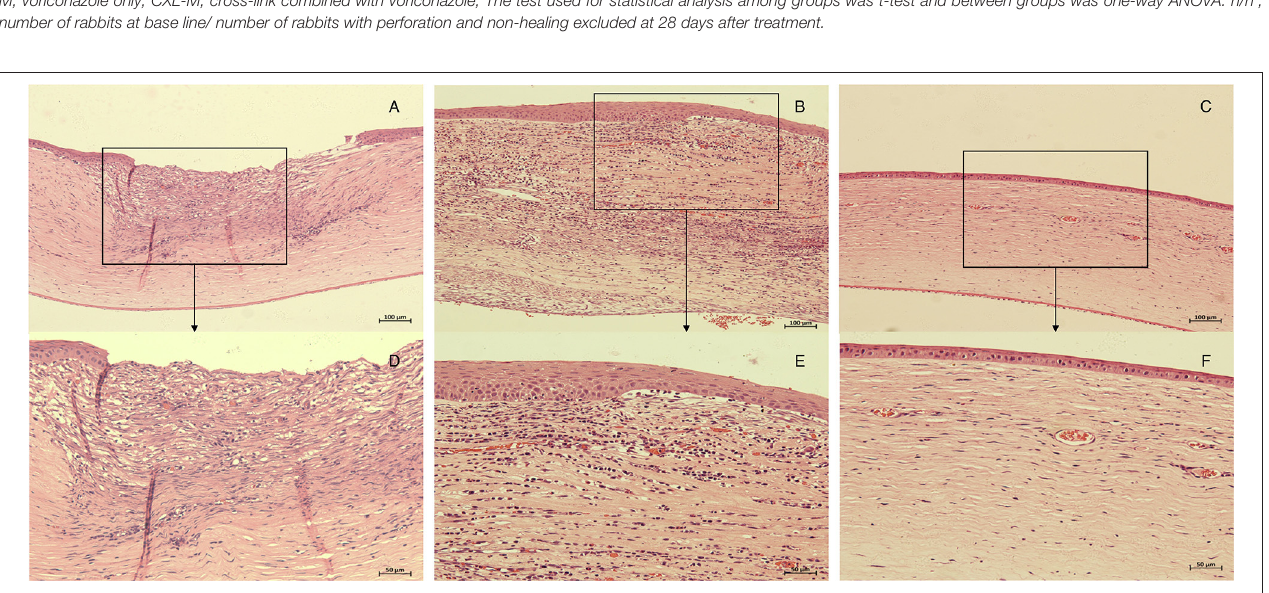
FIGURE 5 | Histopathology of corneas in each group 28 days after treatment (CXL/M). The corneal tissue of rabbit in each group was subject to HE staining. (A,D) , control group; (B,E) , M group; (C,F) , CXL-M group. (D–F) (X40) are the magnification of the content of the boxes in (A–C) (X20),